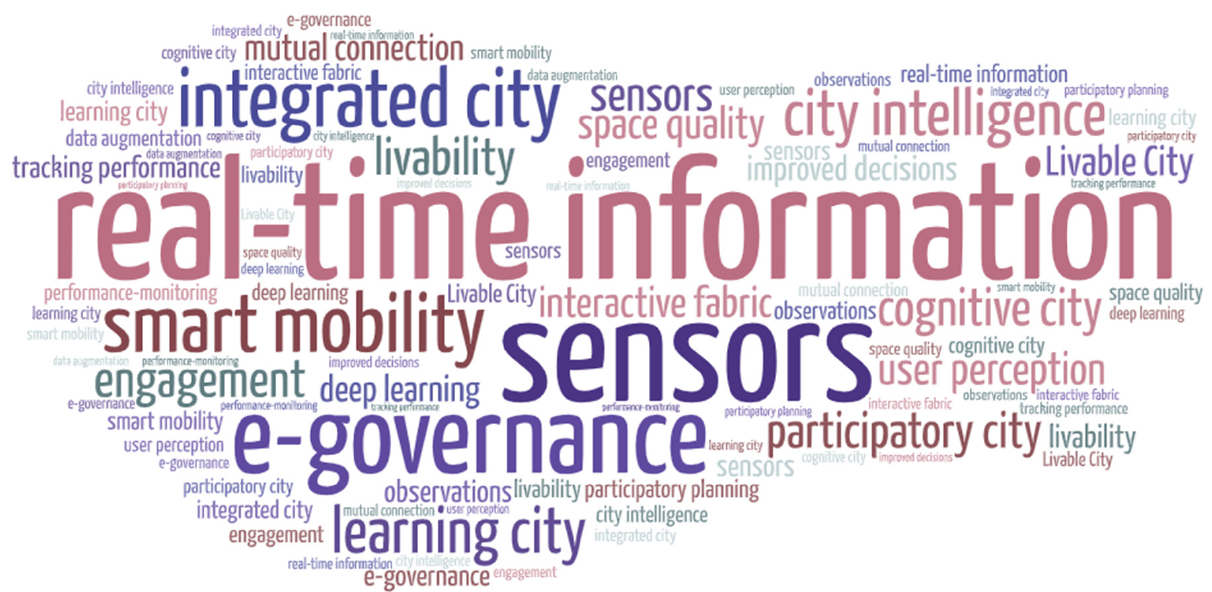
Figure 9. Word-cloud analysis of literature on the experience of the user in the city of the future. Source: Authors.